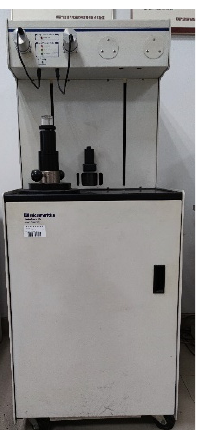
Figure 3. The AutoPore IV 9500 type Mercury Injection